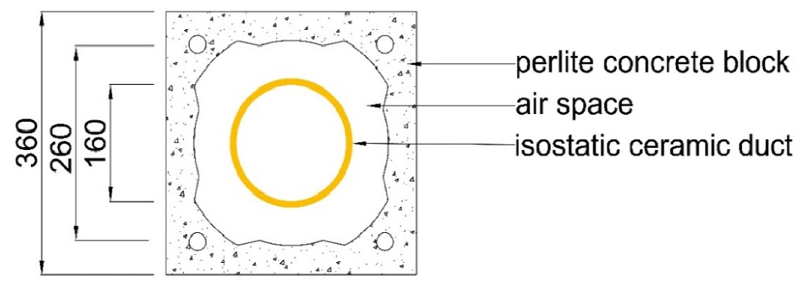
Figure 1. Cross-section of the layers of the analysed chimney (dimensions in mm).